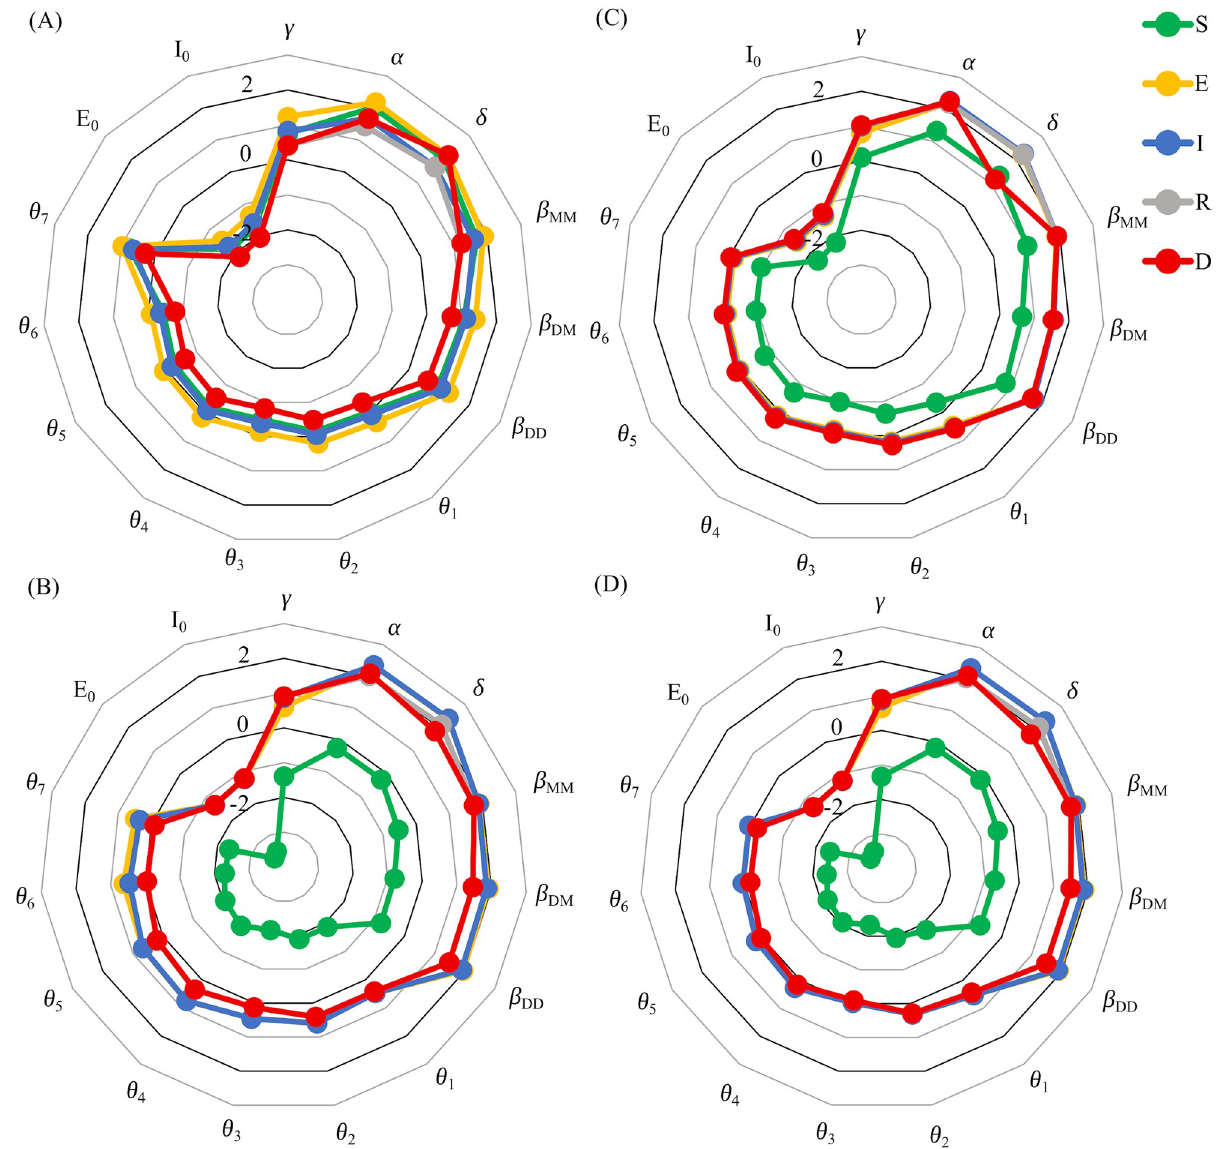
Fig 12. Projected relative sensitivities of the outputs of the Distancing-SEIRD model. Sensitivities of Eqs (3) and (4), to perturbations in the parameter values and initial conditions. Each parameter was perturbed by + 1% and non-zero initial conditions were perturbed by + 1 from their nominal values in Table 1. Simulation time in all plots is 300 days. Moreover, in all plots, the public response function θ ( t ), for t � t from epidemiological data, see Fig 3. Local sensitivities were calculated for different time-dependent future public response functions: (A) Exponential decay of θ ( t > t ) with a half-life of two months. (B) Maintaining periodicity in θ ( t ) for t > t n two weeks. (D) Pulse θ ( t > t ) between 0.4 and 0.8 every two n